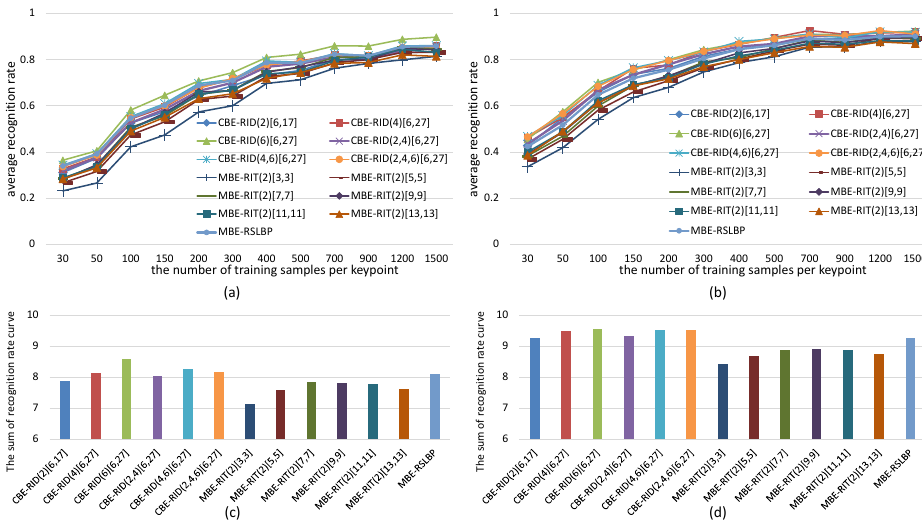
Figure 11. Average recognition rate curves of RandomFerns with respect to increasing training samples of per keypoint. ( a ) Results obtained from gray images; ( b ) Results obtained from color images; Each bar of the histogram in ( c ) is the AUC value of the corresponding feature method in ( a ); Similarly, ( d ) is calculated from ( b ). The histograms show the performance rank of these feature methods.